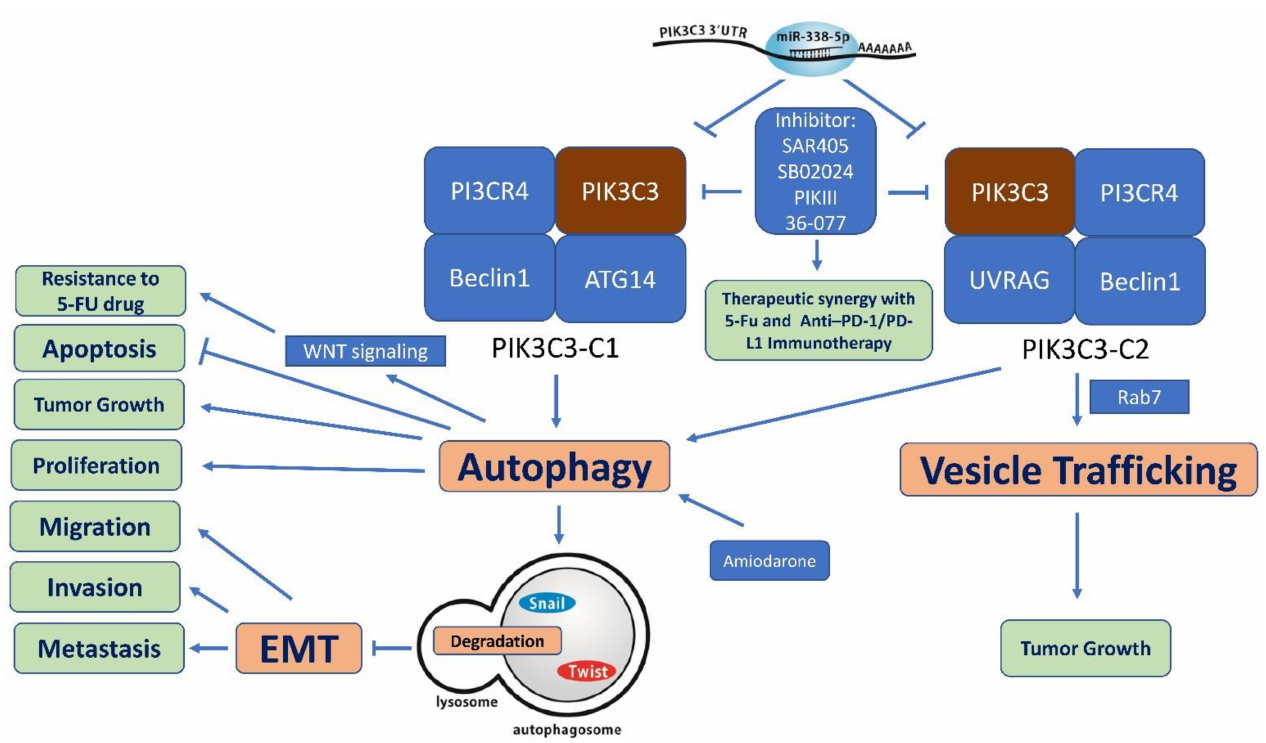
Figure 3. Biological role of PIK3C3 in the tumorigenesis of colorectal cancer. PIK3C3 complex 1 (PIK3C3-C1) is required to initiate autophagy, which induces tumor growth, proliferation, and resistance to 5-FU. PIK3C3 complex 2 (PIK3C3-C2) promotes tumor growth by regulating Rab7. Formation of the PIK3C3 complexes can be inhibited by miR-338-5p and PIK3C3 inhibitors. MiR-338-5p inhibits PIK3C3, and then suppresses the degradation of Snail and Twist by autophagy, resulting in tumor cell migration, invasion, and metastasis [12]. PIK3C3 inhibitors inhibit tumor proliferation and growth, and exhibit therapeutic synergy with 5-FU and anti-PD-1/PD-L1